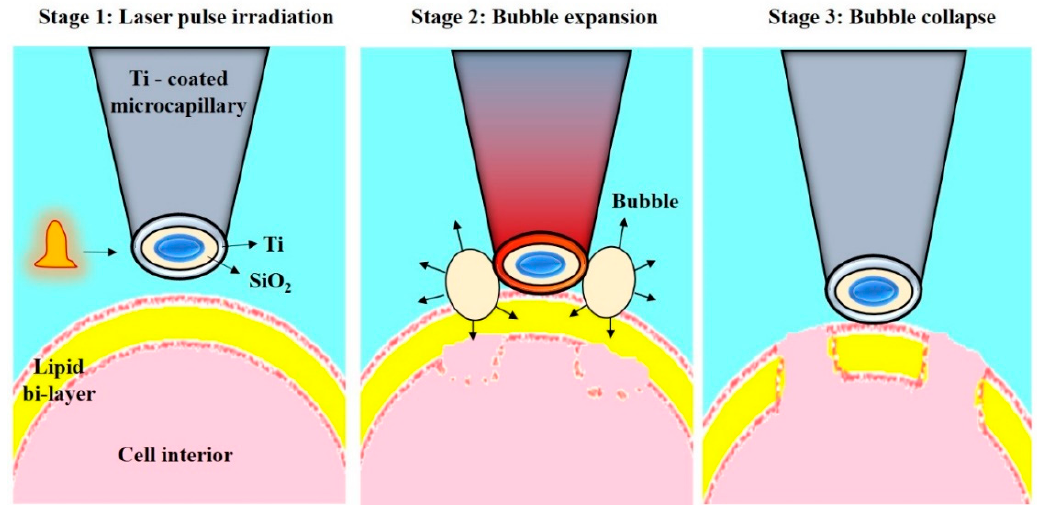
Figure 24. Schematic representation of the Nano blade. The figure depicts the process of cell membrane pore formation by creating micro bubbles. Redrawn from [190].